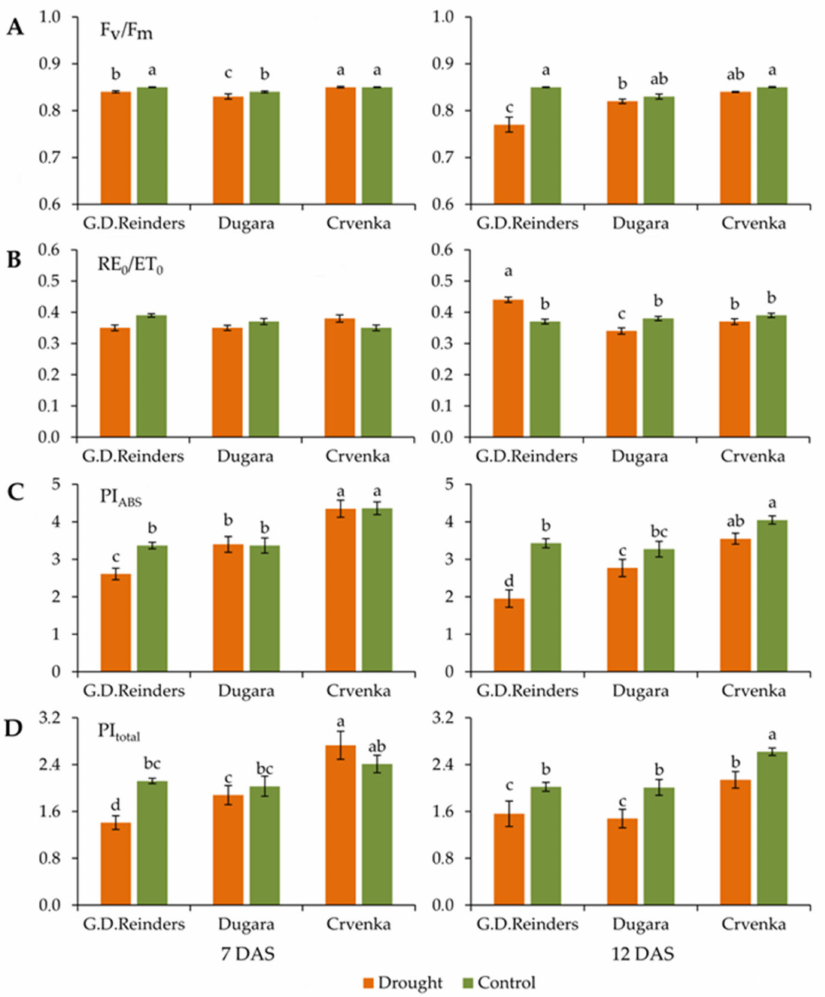
Figure 2. Maximum quantum yield of photosystem II (F v /F m ) ( A ), efficiency/probability with which an electron from the intersystem electron carriers transferred to reduce end acceptors at the PSI acceptor side (RE 0 /ET 0 ) ( B ), performance index on absorption basis (PI ABS ) ( C ), performance index for energy conservation from exciton to the reduction of PSI end acceptors (PI total ) ( D ), measured in control and drought-stressed apple cultivars (“Golden Delicious Reinders”, “Crvenka” and “Dugara”) at 7 and 12 DAS (day after stress). Values are presented as relative units. Values are mean ± SE ( n = 15). Different letters indicate significant differences among treatments and cultivars at p < 0.05 according to the LSD